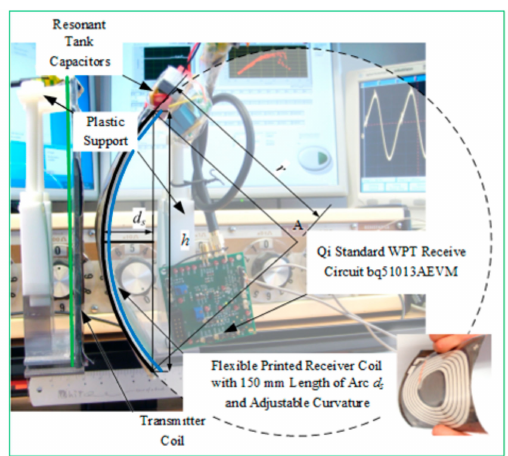
Figure 7. Measuring DC output power of Qi-standard wireless power transfer circuit with adjustable radius support for RX coil (highlighted blue) and planar support for TX coil (highlighted